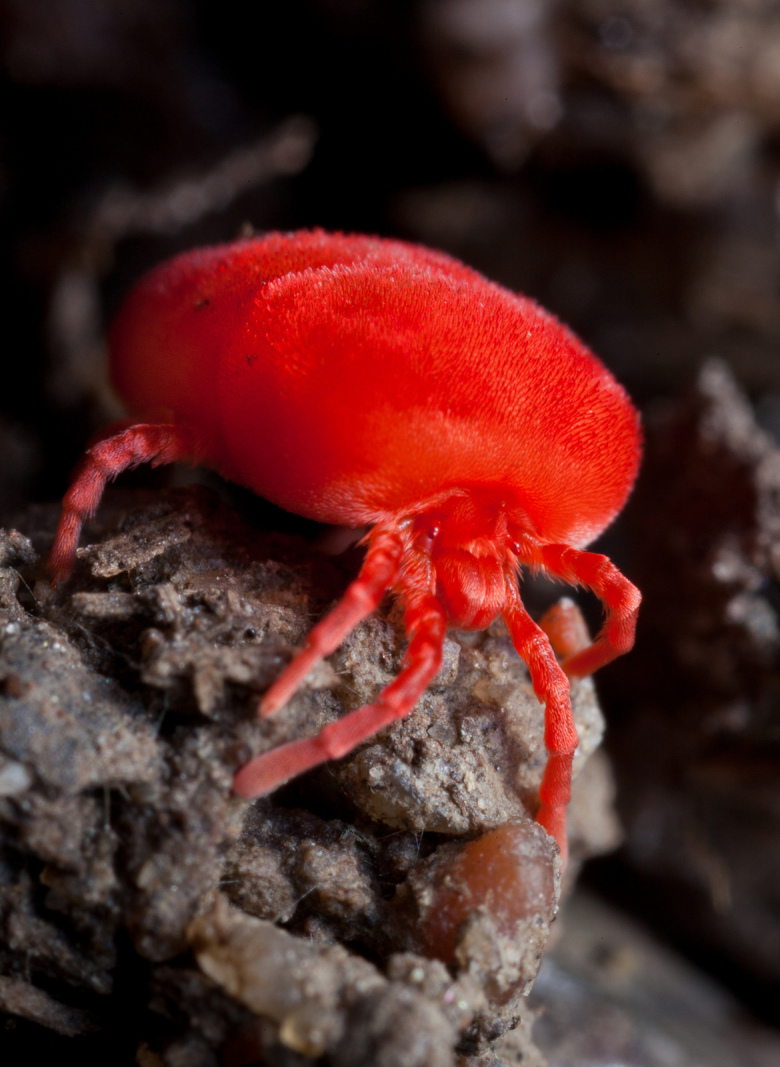
Trombidium sp. Photo John Hallmen.